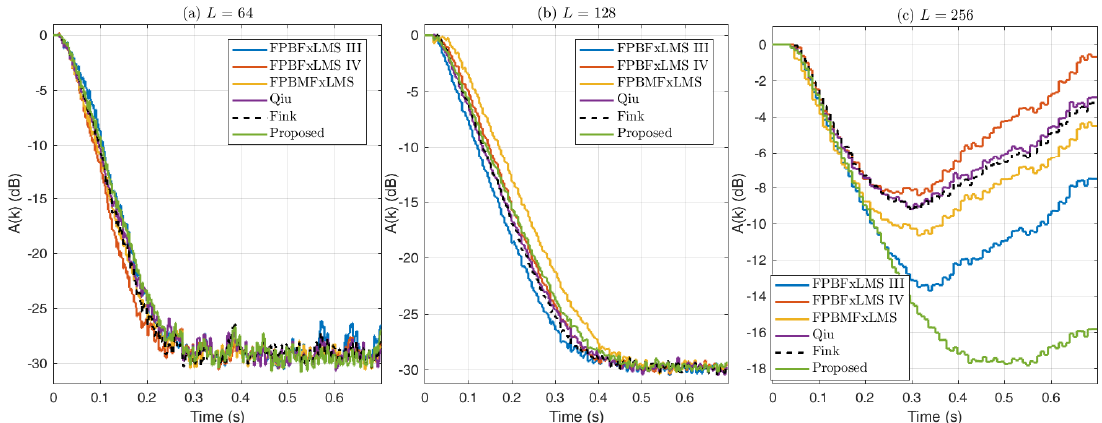
Figure 9. Learning curves of the frequency-domain ANC algorithms with multi-tone signal as input. ( a ) L = 64. ( b ) L = 128. ( c ) L = 256.